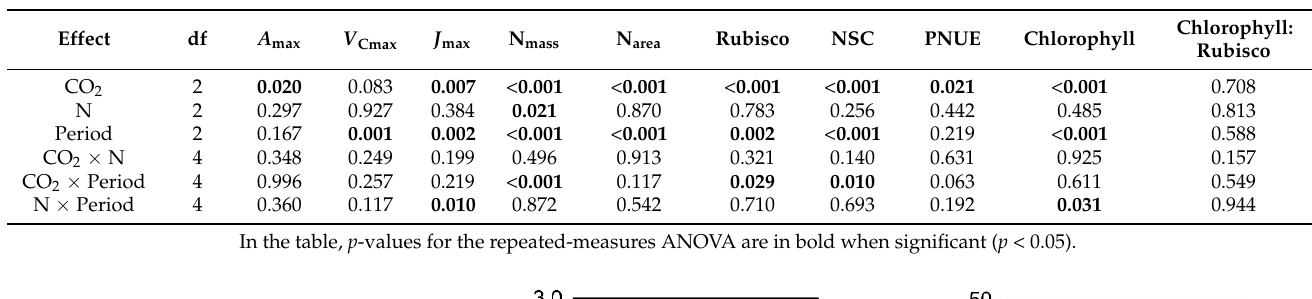
In the table, average of factors ± their standard errors are shown. Different letters next to the mean indicate significant differences among the CO 2 treatments (Tukey’s test, p < 0.05). n.s.: non-significant. Table 1. p -Values of a three-way ANOVA across period for maximum photosynthetic rate ( A max ), maximum carboxylation rate ( V Cmax ), RuBP regeneration rate ( J max ), nitrogen per unit mass (N mass ), nitrogen per unit area (N area ), Rubisco per unit area (Rubisco), nonstructural carbohydrates per unit area (NSC), photosynthetic N use efficiency (PNUE), chlorophyll per unit area (Chlorophyll), and ratio of chlorophyll and Rubisco measured in Fraxinus rhynchophylla grown at three different CO 2 chambers (ambient: aCO 2 ; ambient × 1.4: eCO 2 1.4; ambient × 1.8: eCO 2 1.8) and three different N treatments (N1: